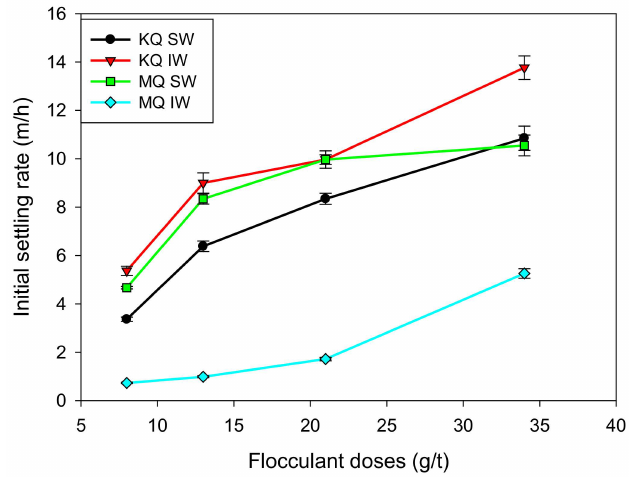
Figure 5. Initial settling rate at varied flocculant dosage for KQ and MQ synthetic tailings in SW and IW. Mixing rate 180 rpm, solids concentration 8 wt% (clay/quartz 10/90), flocculation time 20 s, pH